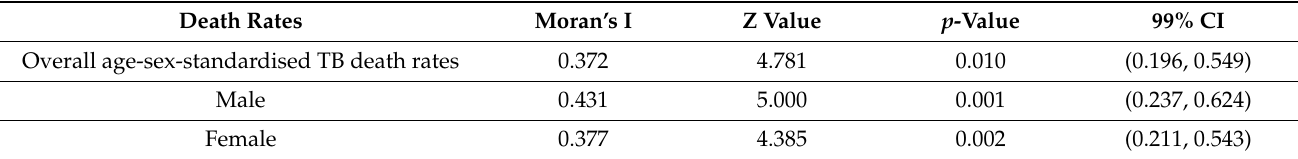
Figure 3: Local Moran’s I Clustering of the Overall (left), Male (middle) and Female (right) Age Table 2. Global Moran’s Indices, Z and p -values for the overall, male, and female age-sex-standardised TB death rates, 2010.